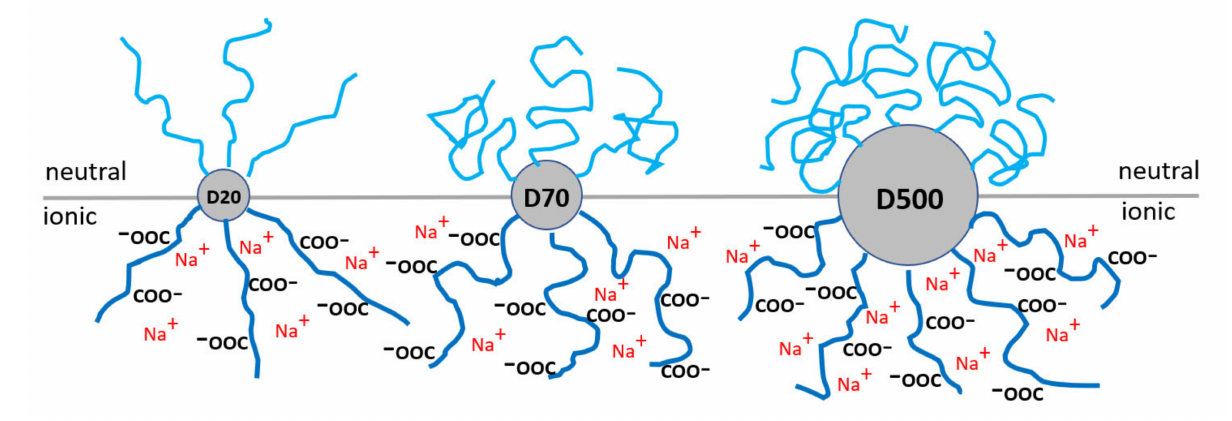
Figure 1. Schematic representation of the conformational state of DXX-PAAm neutral form (top portion) versus DXX-PAAc ionic form (bottom portion) for different size dextran